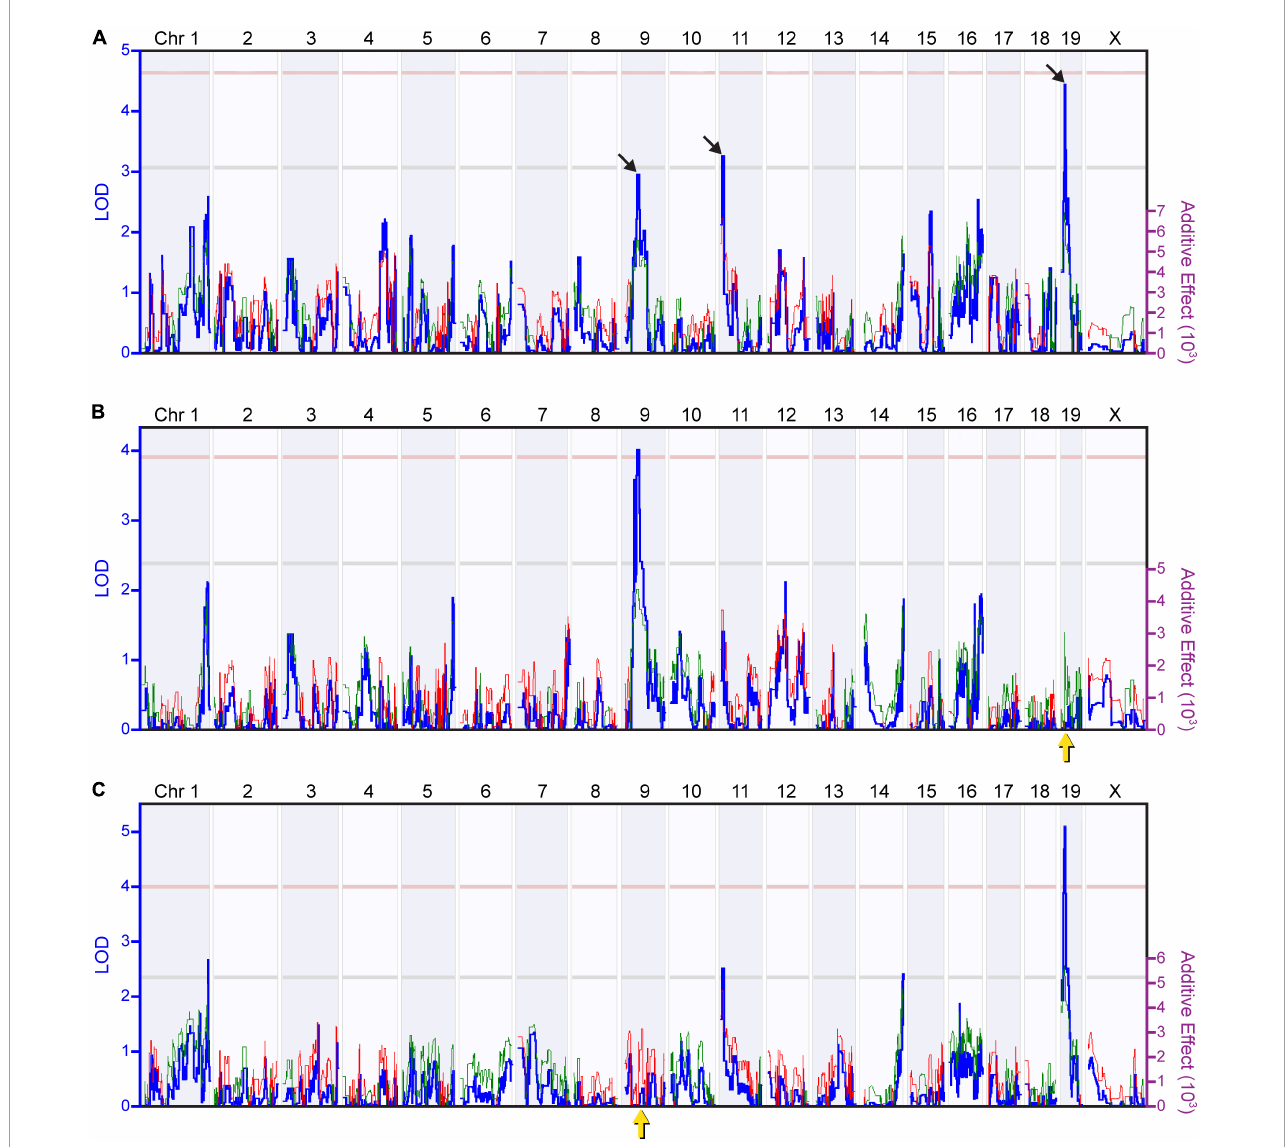
FIGURE2 Quantitative trait locus (QTL) mapping identifies discrete genomic loci controlling the number of AII amacrine cells. (A) Mapping the variation in AII amacrine cell number revealed three suggestive or near-suggestive genomic loci, on Chrs 9, 11, and 19 (black arrows). The blue trace plots the logarithm of the odds (LOD) score, indicated along the left Y axis. The pink and gray horizontal dashed lines indicate respective significant and suggestive thresholds, respectively, for the LOD score determined through 2,000 permutation tests of the strain data. The red and green traces plot the additive effect of A or B alleles at each genomic locus upon AII cell number, indicated along the right Y axis. The presence of A alleles on Chrs 9 and 19 correlated with an increase in AII amacrine cell number, whereas the presence of B alleles on Chr 11 correlated with an increase in AII amacrine cell number. (B) Using composite interval mapping to control for the effect of the variation attributed to the QTL on Chr 19 (yellow arrow) raised the LOD score for the Chr 9 locus above the significant threshold. (C) Conversely, controlling for the effect of the variation attributed to the QTL on Chr 9 (yellow arrow) raised the LOD score for the Chr 19 locus far above the significant threshold. These two composite interval maps validate the presence of the two